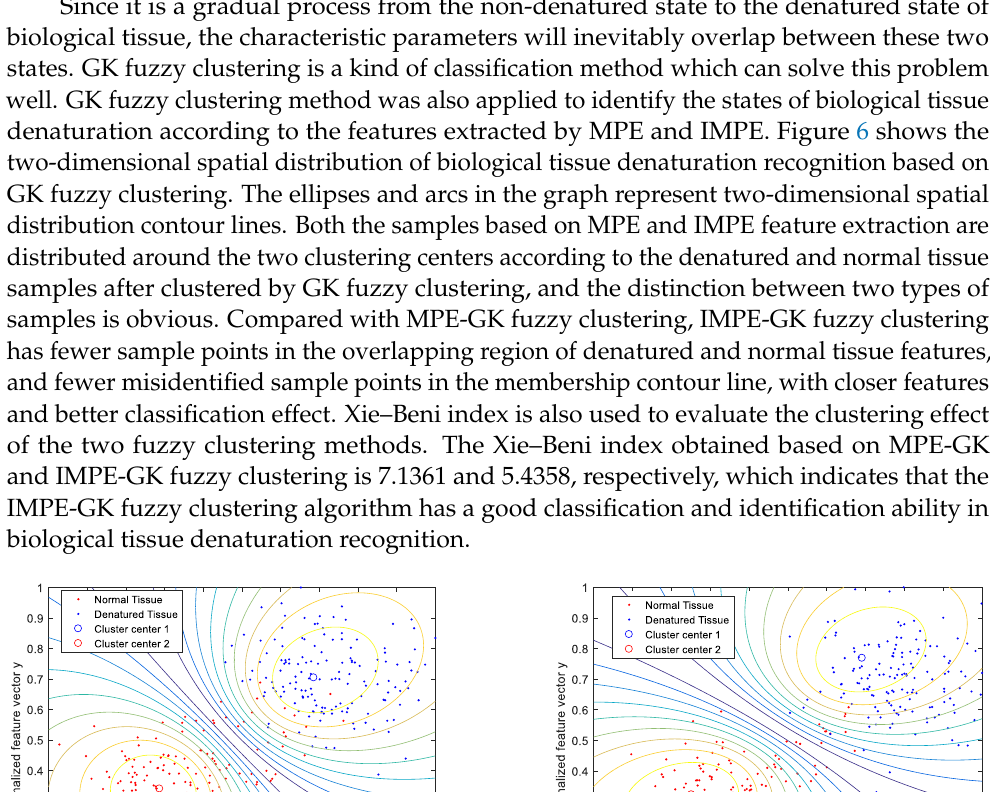
Figure 5. Recognition of denatured and non-denatured tissue based on support vector machine (SVM): ( a ) MPE-SVM; ( b ) IMPE-SVM.